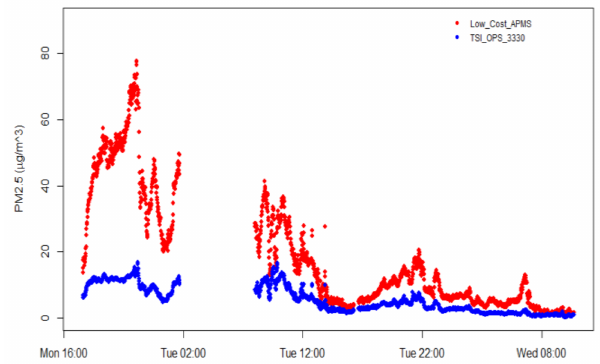
Figure 7. Time series of PM2.5 concentration measurements with 1 min resolution (data collected from March 6 to March 8,